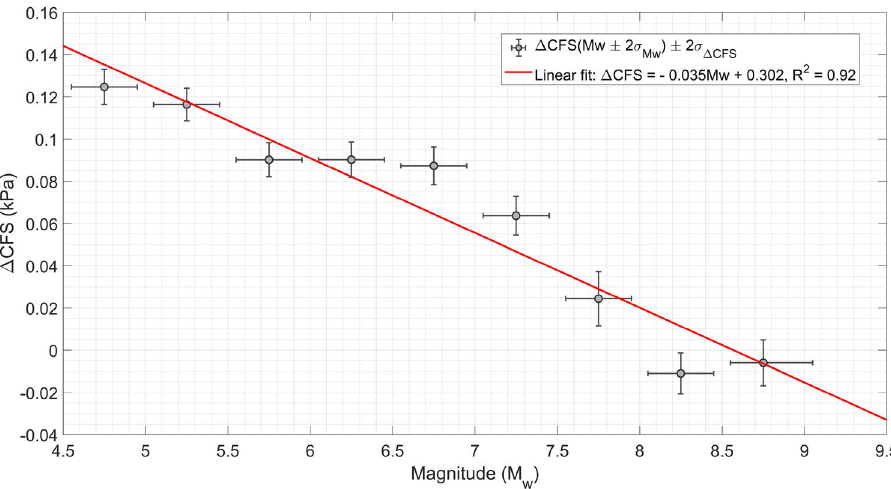
Figure 7. Moderate seismicity is more strongly triggered by solid Earth tides than larger earthquakes. Stress perturbations directly affect small unstable faults more likely than larger ones, while fracture propagation over large patches is almost completely controlled by their internal state of stress. The plot is obtained by averaging the tidal Coulomb Failure stress values over groups of earthquakes with different moment magnitudes. The figure is realized by analysing worldwide seismic events listed in the USGS catalog between 2001 and 2021, M w ≥